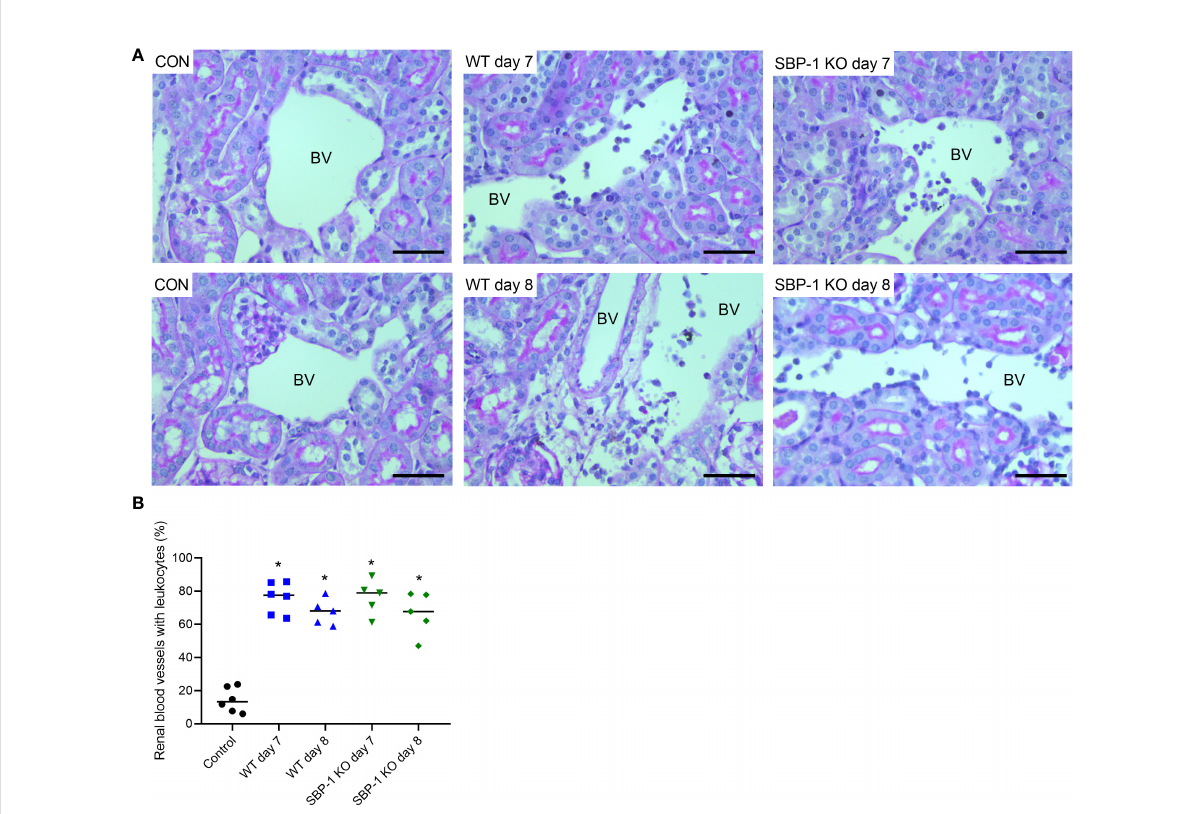
FIGURE 7 Similar intravascular accumulation of leukocytes in the kidneys of WT and SBP-1 KO infected mice. C57BL/6 mice were infected with WT and SBP-1 KO Pb NK65 parasites and at day 7 and 8 p.i. kidneys were dissected. Kidney sections were stained with PAS. (A) Representative images are shown (original magni fi cation x40, bar = 50 µm). BV indicates blood vessel on renal section. (B) Percentage of renal blood vessels with intravascular accumulation of leukocytes Asterisks above data points indicate signi fi cant differences compared to control mice, *p < 0.05. Data of two experiments, Control: n = 6, WT d7-d8: n = 5-6, SBP-1 KO d7-d8: n = 5. Mann-Whitney U test with Holm-Bonferroni correction for multiple testing (number of tests = 6) was performed in panel